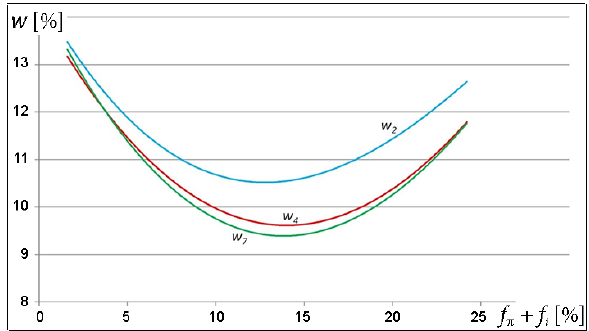
Figure 13. The dependence between the changes of the moisture trend line in the middle of the soil sample and the fine fraction content